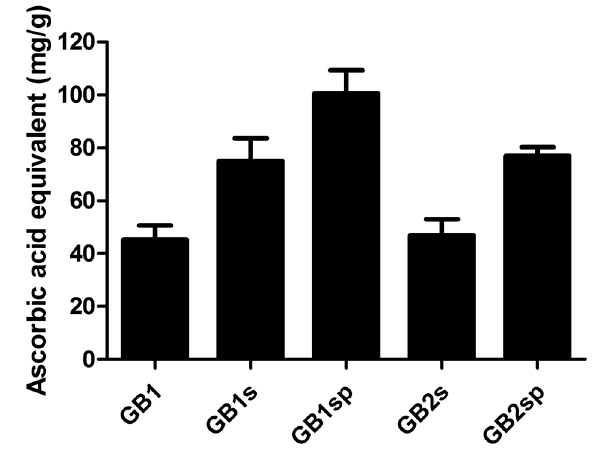
Figure 3. Total antioxidant capacity of extracts from Gracilaria birdiae. The results are expressed as ascorbic acid equivalents. Each value is the mean ± standard deviation of two determinations: a, b, different letters refer to significant difference ( p < 0.05) between each extraction.